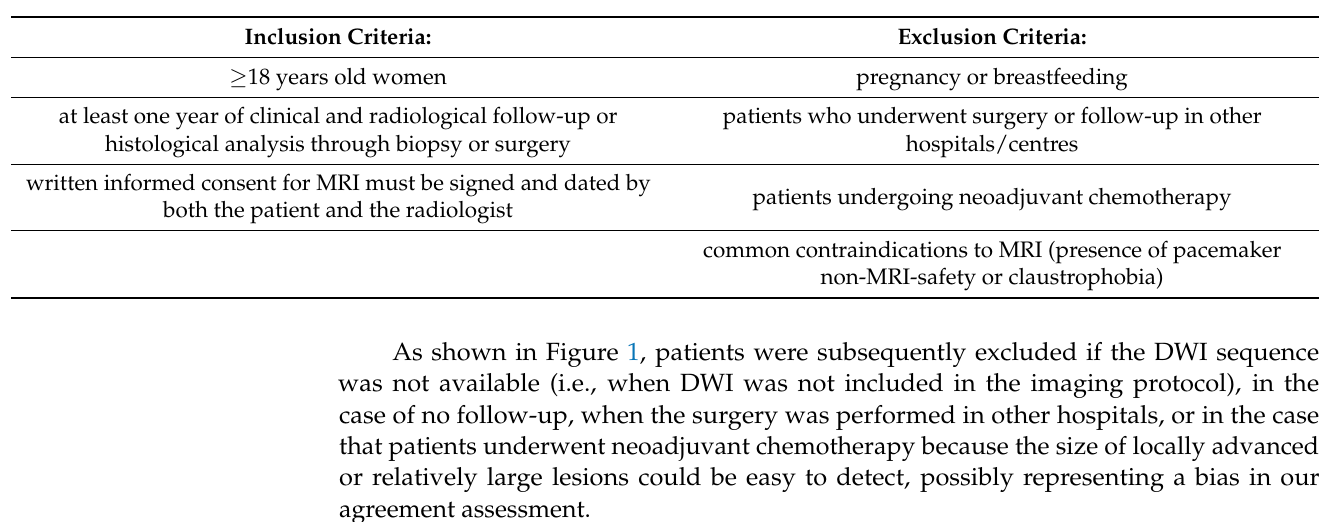
Table 2. Inclusion and exclusion criteria. MRI: Magnetic Resonance